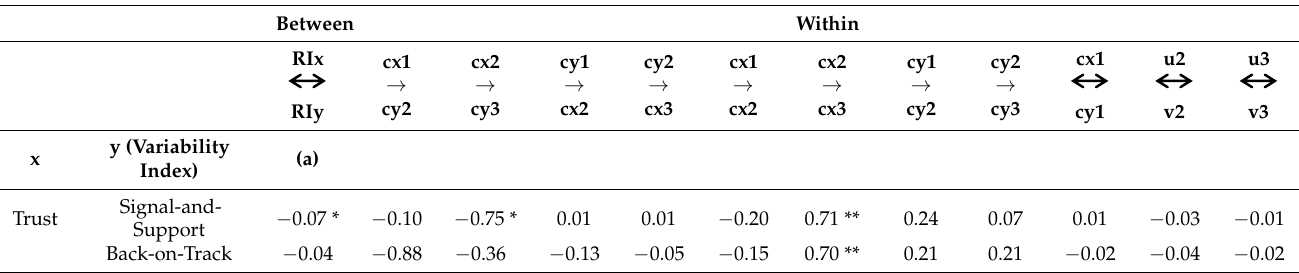
Table 5. RI-CLPM results with Trust.